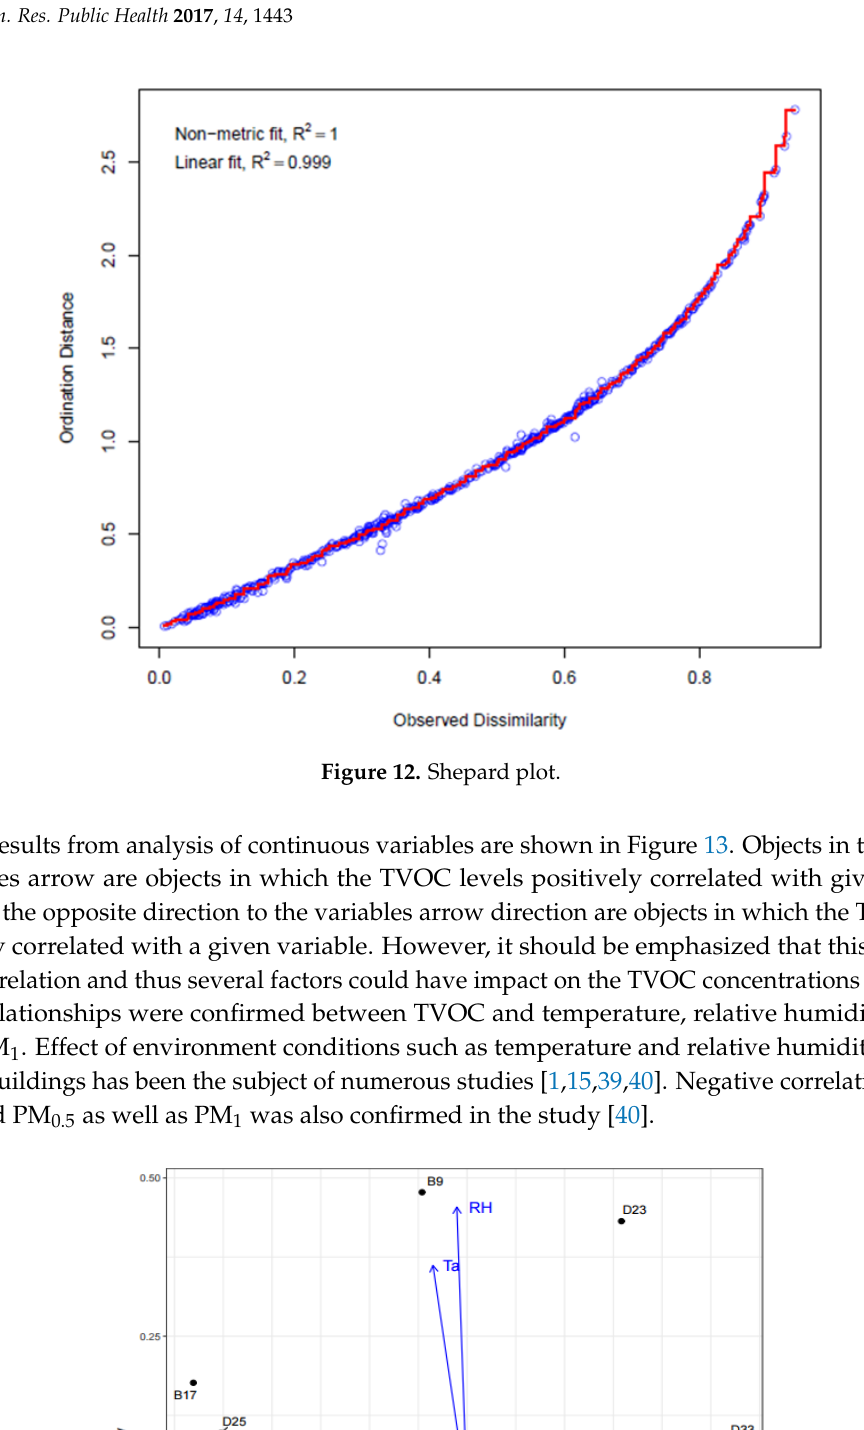
Table 2. Results from envfit.